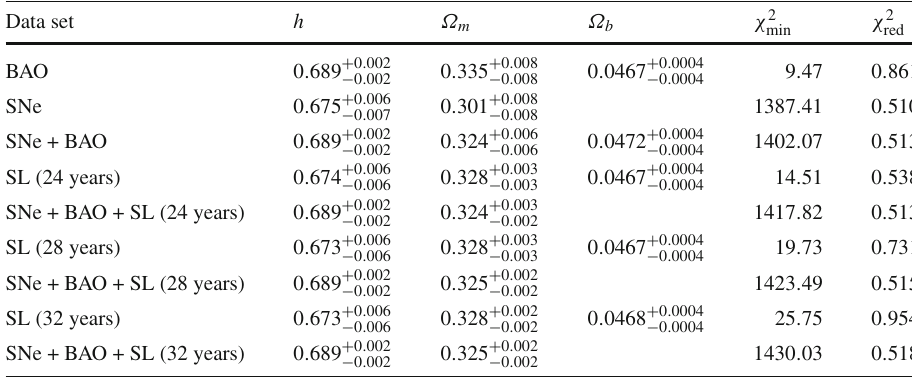
Table 2 Parameter results of the Λ CDM